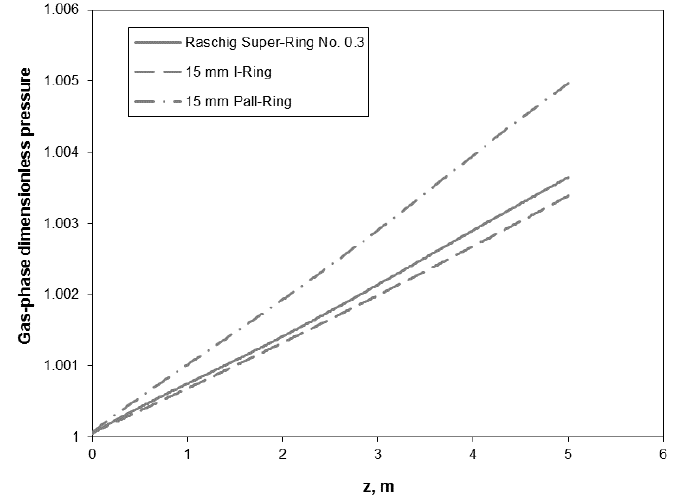
Figure 7. Steady-state axial profiles of gas-phase dimensionless pressure in random packed-bed columns (Base case operating conditions – Table 2; P = 2.5 MPa; H = 5 m).